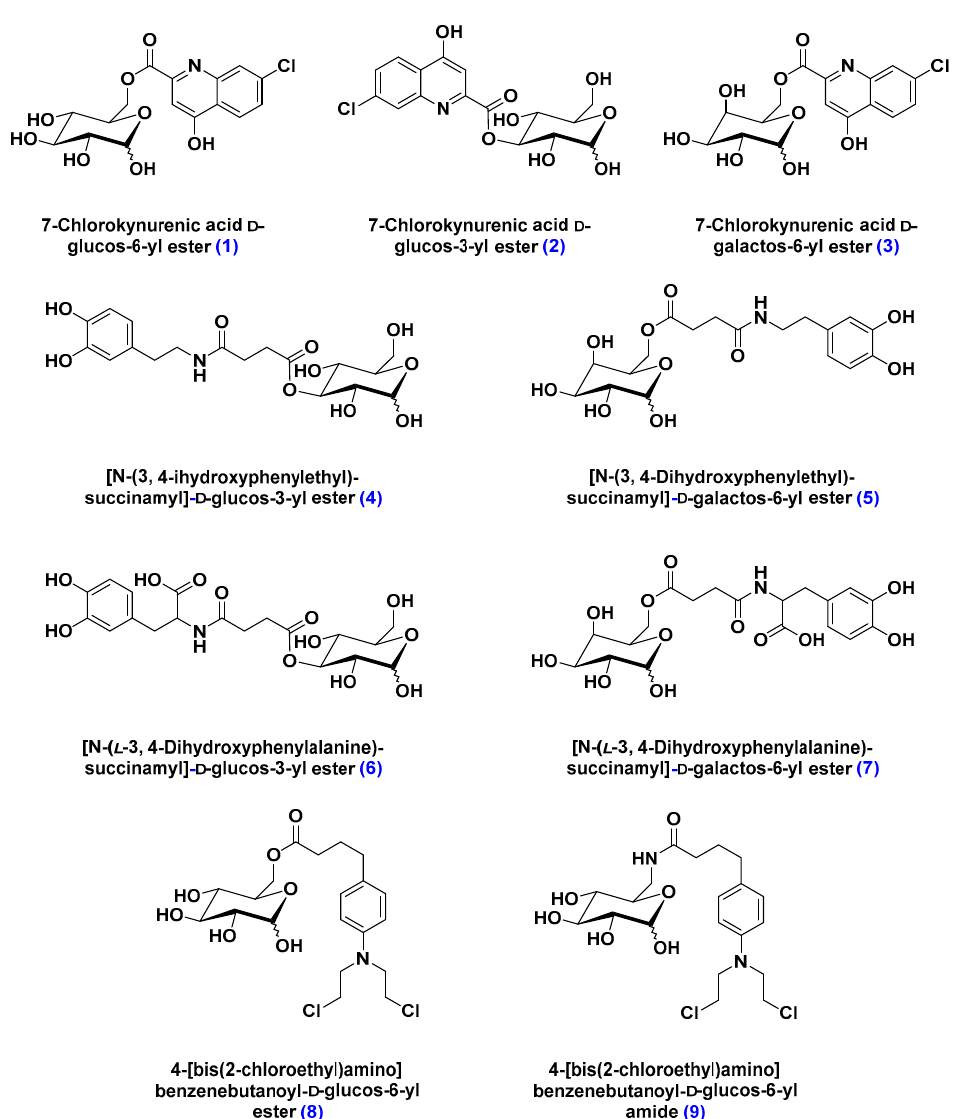
Figure 11. Structure of sugar-conjugates designed to highlight the structural requirements of GLUT-mediated transport of therapeutic material. Compounds 1–3 are glucose and galactose conjugates of the BBB-impermeable antidepressant 7-chlorokynurenic acid. Compounds 4–7 are glucose and galactose conjugates of l -DOPA, a dopamine precursor used for the management of Parkinson’s disease symptoms. Compounds 8 and 9 are glucose conjugates of chlorambucil, a BBB-impermeable chemotherapeutic reagent. The three studies revealed the sensitivity of this approach to the conjugate’s size and the ligation regiochemistry of its